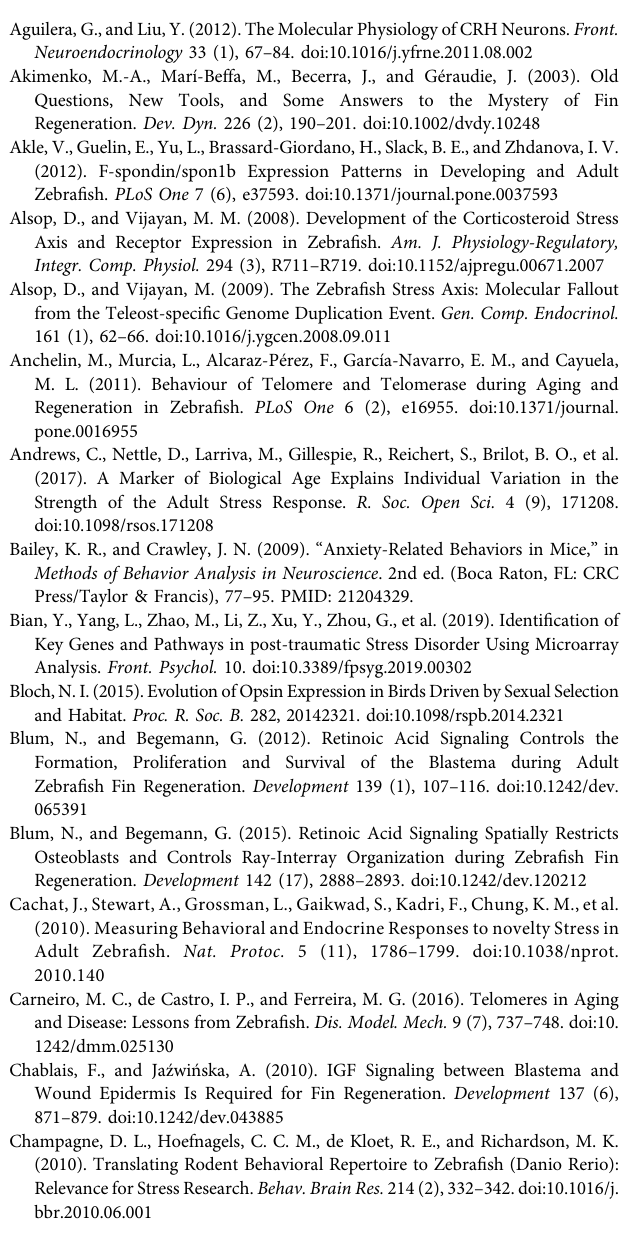
Supplementary Figure S5 | Aggression signals after exposure to the stress protocol in young stressed fi sh. (A – C) Caudal fi ns from three different young stressed fi sh that show bites and signals of aggression after the UCS protocol and before amputation. We also show the complete regeneration of the caudal fi ns, both in the wounds and in the amputation. Supplementary Figure S6 | Visualization of the zebra fi sh behavior during Open Field test. Track visualization and heatmap visualization of the swimming patterns of three representative fi shfromeachexperimentalgroup(control,stress)in (A) youngand (B) old zebra fi sh. Rows are the same representative fi sh during the same recording.